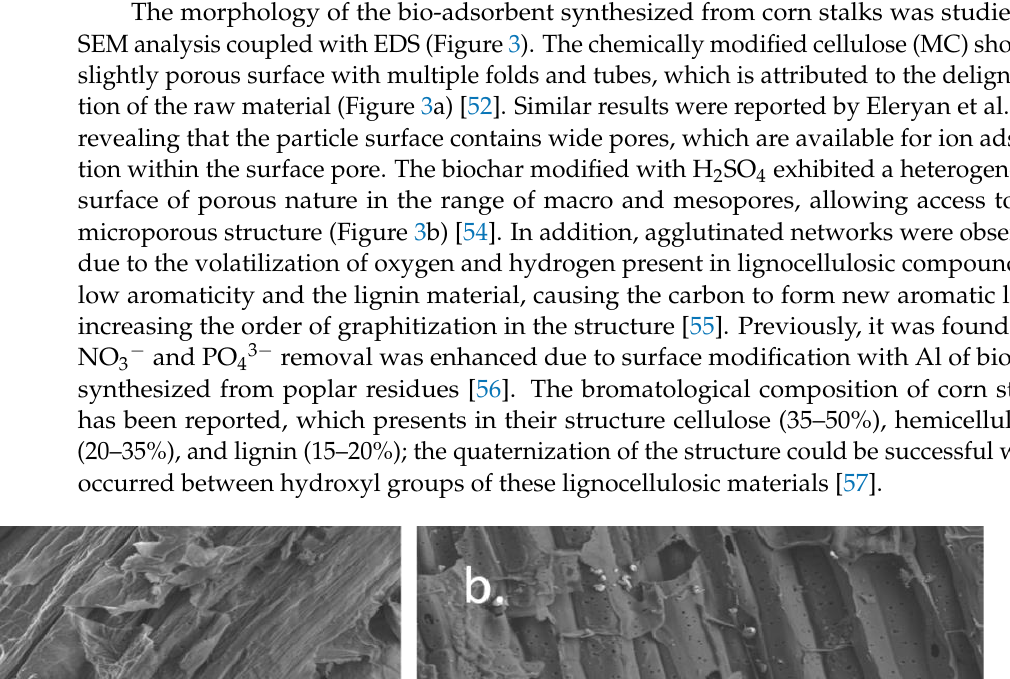
Table 1. Bio-adsorbent elementary composition determined from the EDS technique.